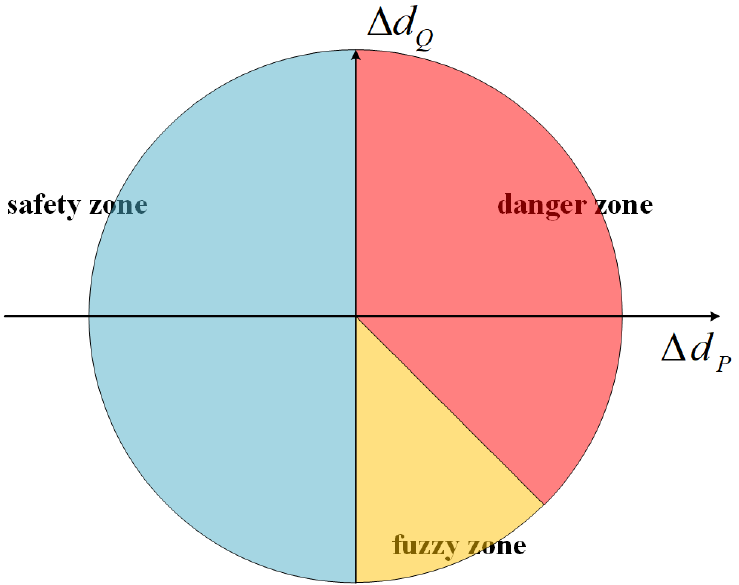
Figure 2. Distribution of uncertainty evolutionary zones in the navigation environment.